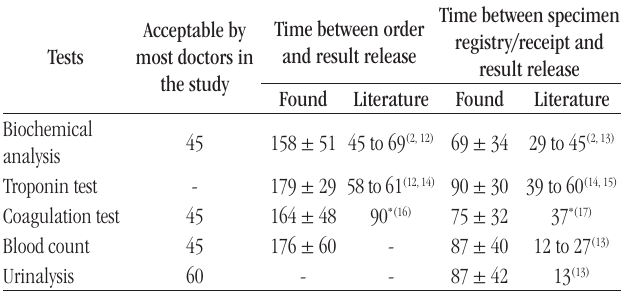
Results are expressed as mean ± standard deviation in minutes. * Data regarding routine TAT, not specifically as emergency test such as the other presented literature data. AED: Adult Emergency Department; TAT: turnaround